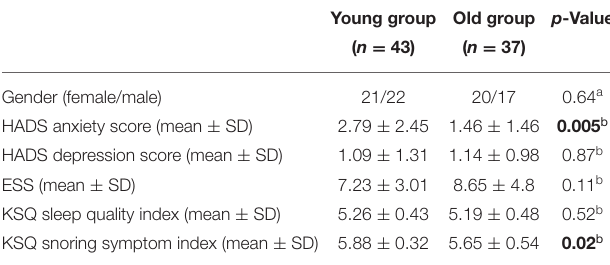
TABLE 1 | Demographic information of subjects in the old group and young group.